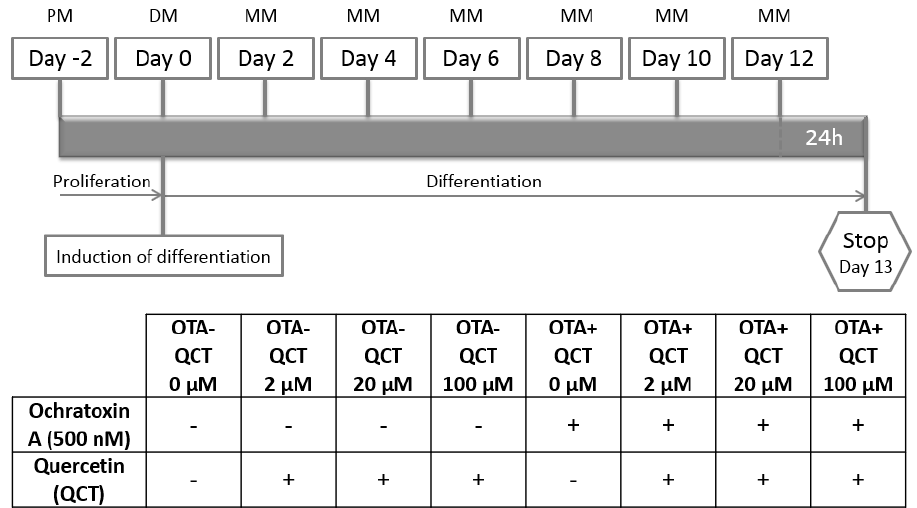
Figure 7. General scheme of research methodology. PM—proliferation medium, DM—differentiation medium, MM—maintenance medium.